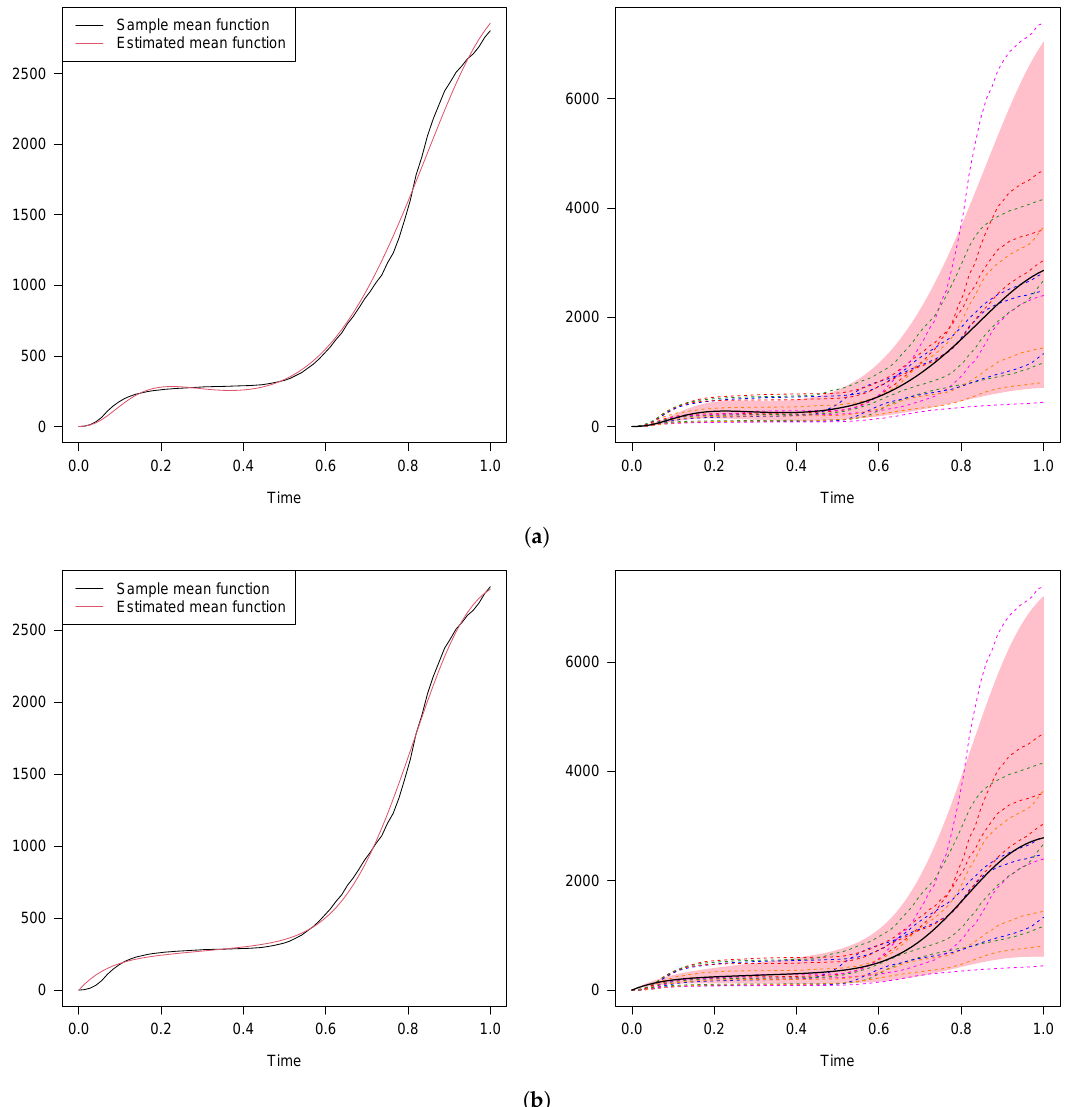
Figure 3. Study of infected: Sample and estimated mean functions ( left ) and 95% confidence band for the mean func- tion together with the sample paths ( right ) for ( a ) the multi-sigmoidal Gompertz model and ( b ) the multi-sigmoidal Weibull